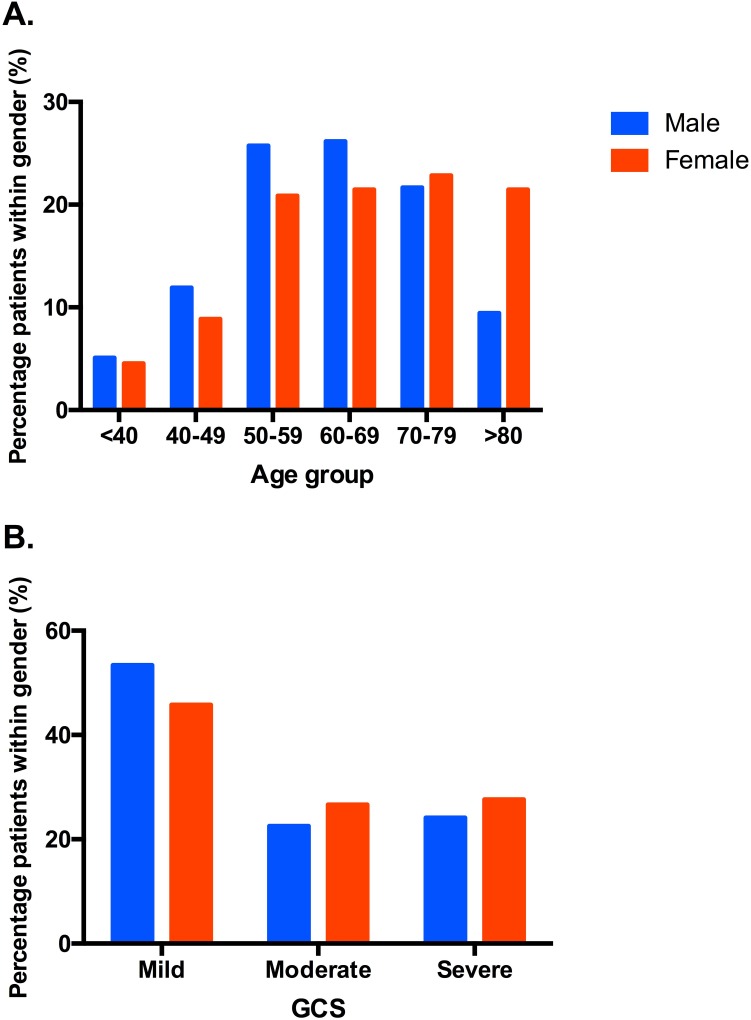
Percentage of patients with ICH by age and Glasgow Coma Scale (GCS) severity categories in relation to gender at admission.(A) Males were more likely to get ICH than females in all age groups, except for the age group >80 years. (B) There were no statistically significant gender differences when GCS was categorized into mild, moderate, and severe. Mild GCS impairment is defined as GCS >12, moderate impairment as 9–12 and severe as ≤ 8.